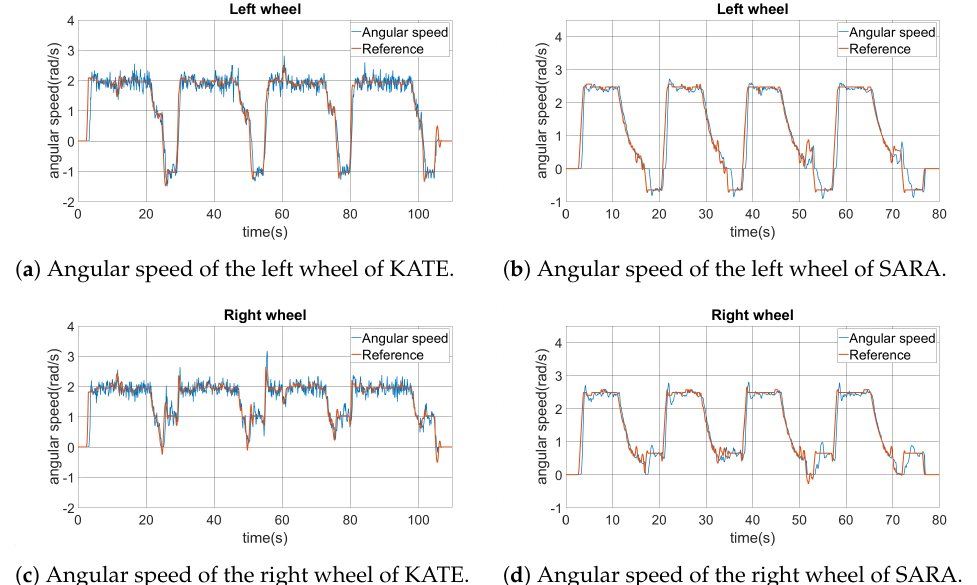
Figure 20. Comparison of angular speed between KATE and SARA left and right drive